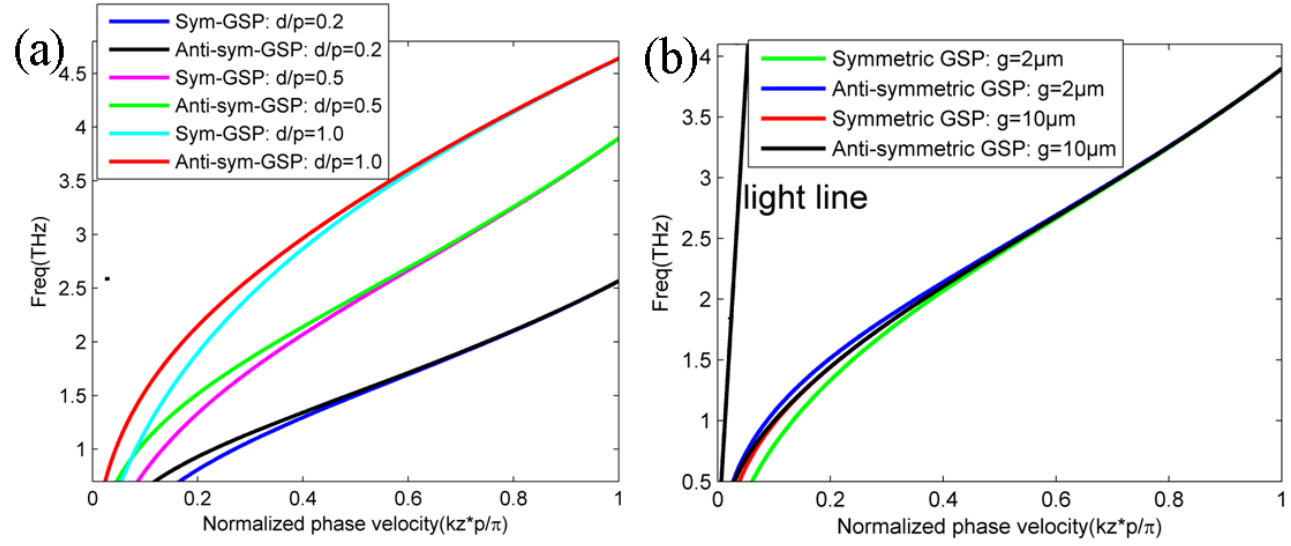
Figure 5. Symmetric and antisymmetric GSP dispersion diagrams with different ( a ) graphene ribbon width d and ( b ) gap size g between upper and lower graphene metasurfaces in Figure 1. Other parameters are the same as those in Figure 2.